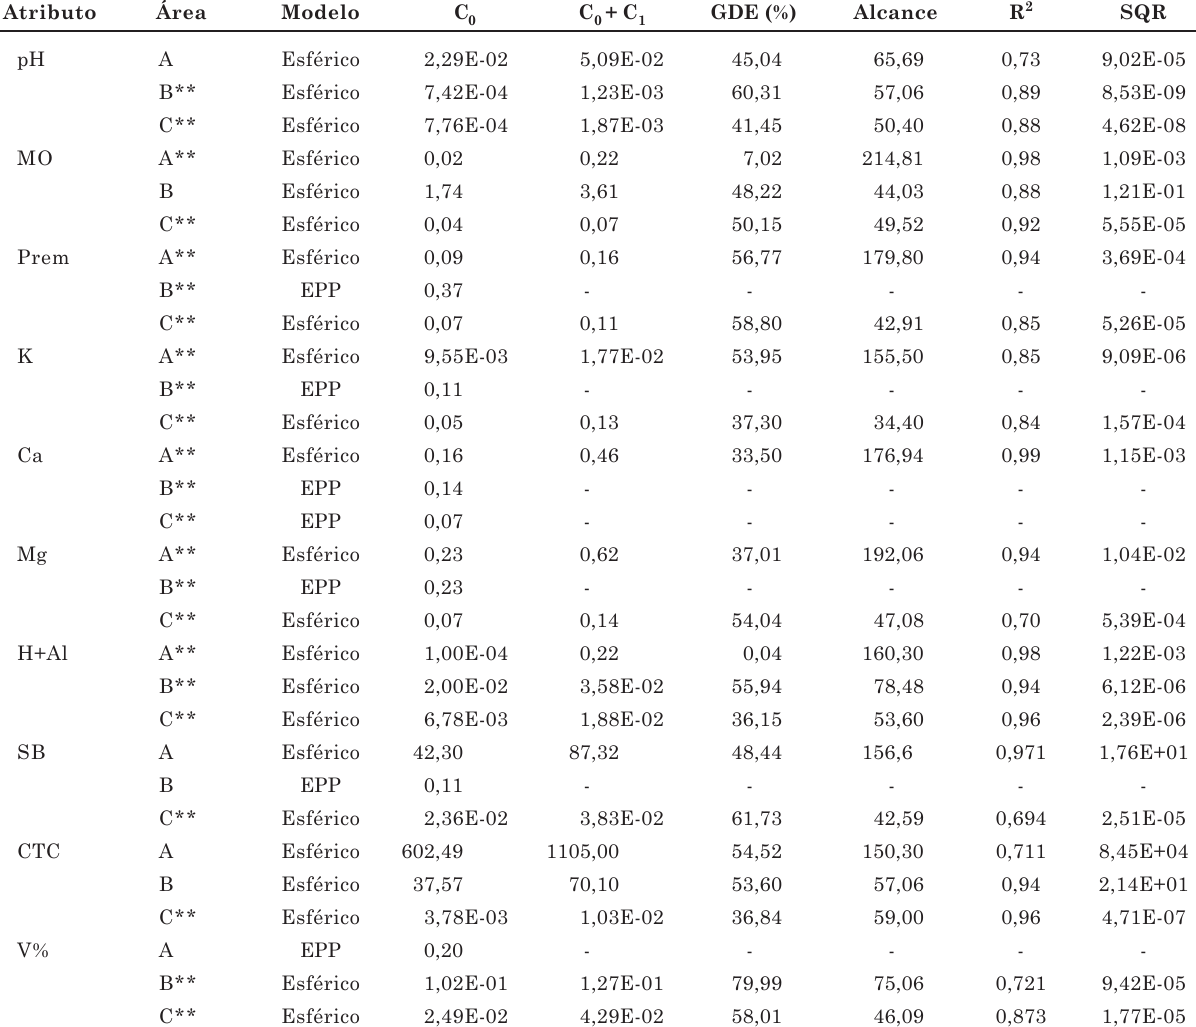
Quadro 6. Modelos e parâmetros ajustados aos variogramas experimentais dos atributos químicos dos solos estudados na profundidade 0,2-0,4